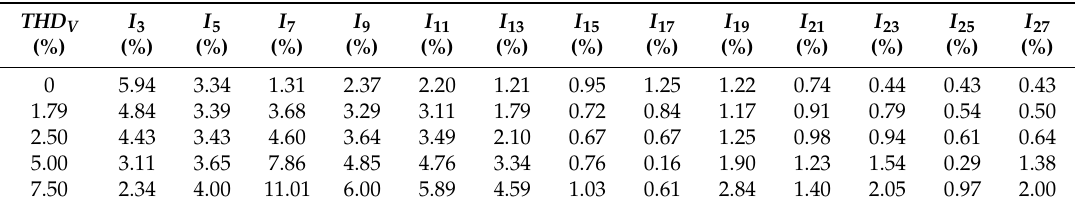
Table 7. List of measured selected RMS values of harmonics I h in relation to the basic harmonics for LED1.